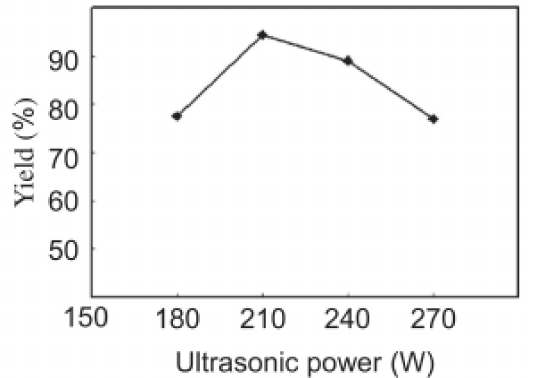
Figure 5. Effect of biodiesel yield for ultrasonic power. Reproduced with permission from Deng et al., Production of biodiesel from Jatropha oil catalyzed by nanosized solid basic catalyst; published by Elsevier, 2011